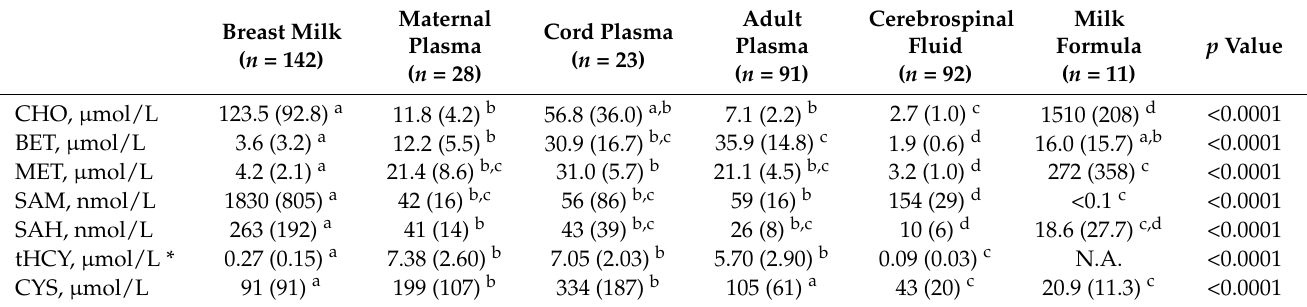
Table 1. One-carbon metabolite concentrations in biofluids and milk formula.